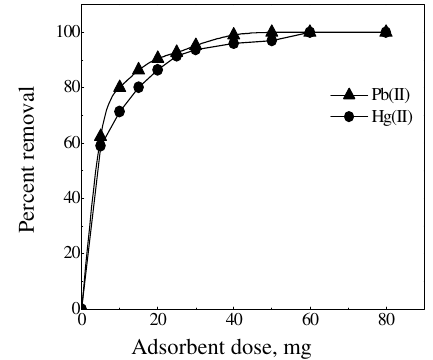
Figure 4. Effect of adsorbent dose on the removal of Pb(II) and Hg(II) ions on CSC (Initial Concentration- 10 mg L -1